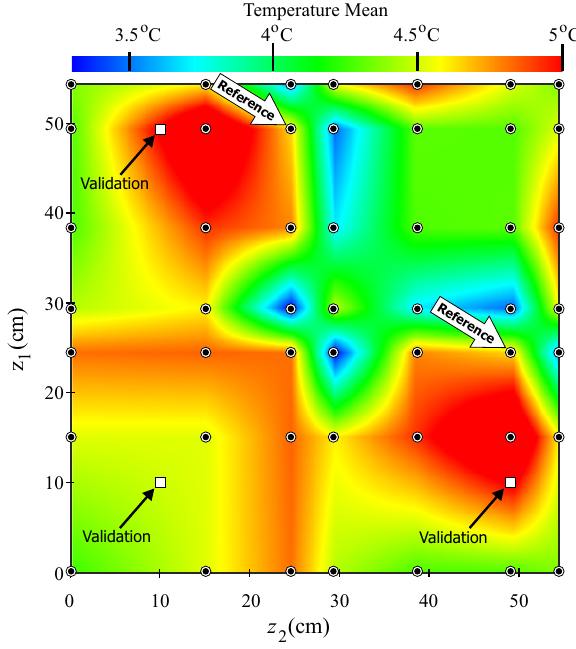
Figure 8. Thermal simulation using bilinear